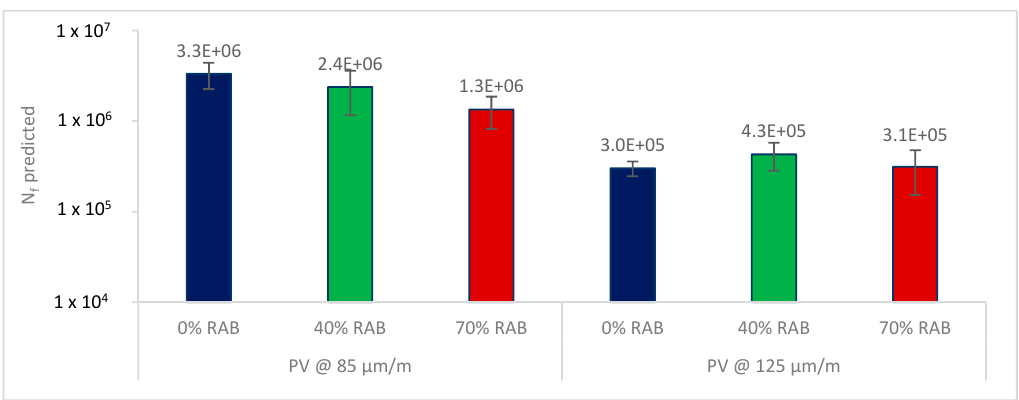
Figure 7. Predicted fatigue life of the asphalt scale, per mixture, for the two strain levels based on the PV (Equation (4)).